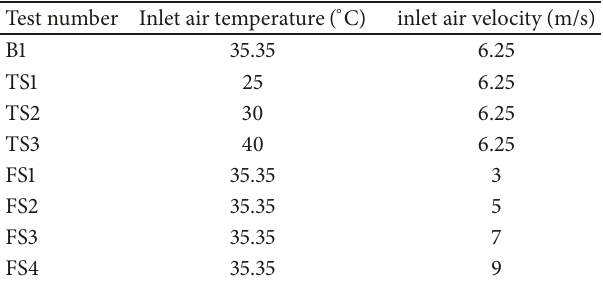
Table 4: The specific conditions for